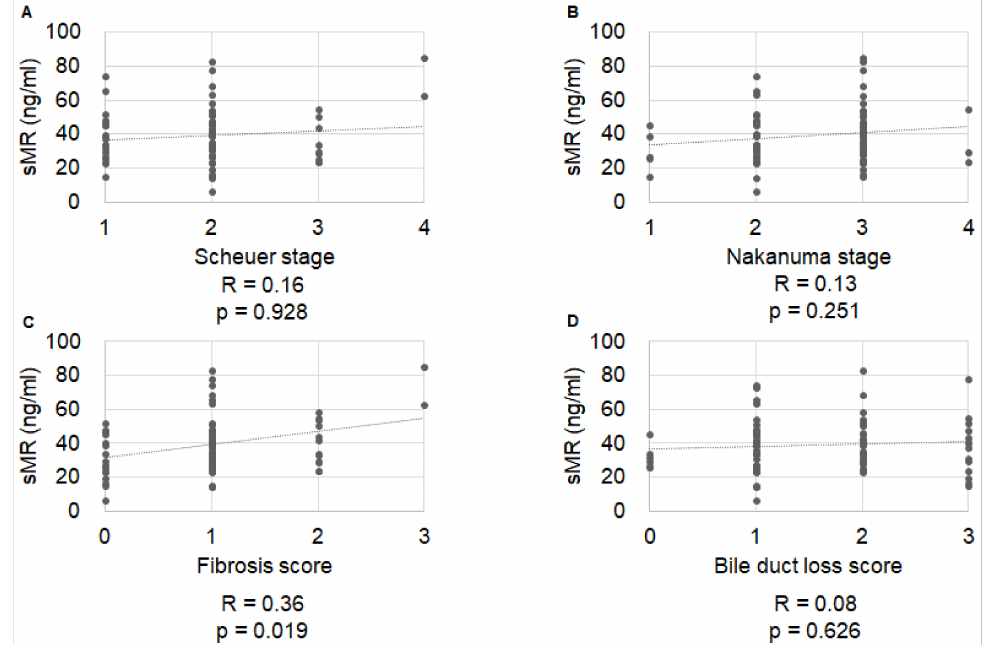
Figure 1. Correlation of soluble mannose receptor with histological stage. ( A ) Scheuer stage, R = 0.16, p = 0.928; ( B ) Nakanuma stage, R = 0.13, p = 0.251; ( C ) Nakanuma fibrosis score, R = 0.36, p = 0.019; ( D ) Nakanuma bile duct score, R = 0.08, p =